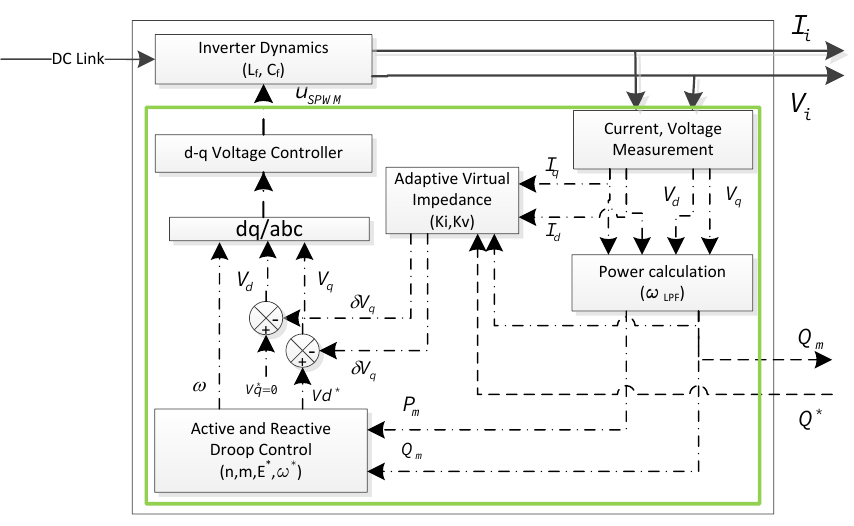
Figure 8. IDG CPES module (adaptive virtual